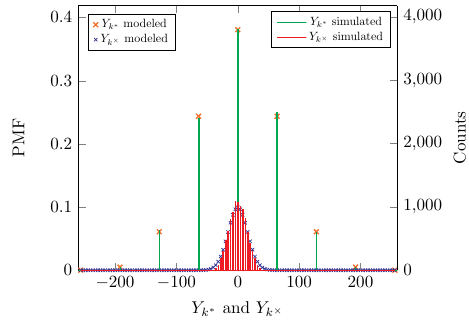
(cid:1) for (cid:0) Figure 3: The histogram for the simulation | Figure 2: Pr | Y k ∗ | > max | Y n ∈ k × k × (using 10 thousand trials) matches the theo- { 4 , · · · , 16 } and m ∈ { 4 , · · · , max( n, 12) } retical analysis when ( n, m ) = (8 , and |K| = 2 n .